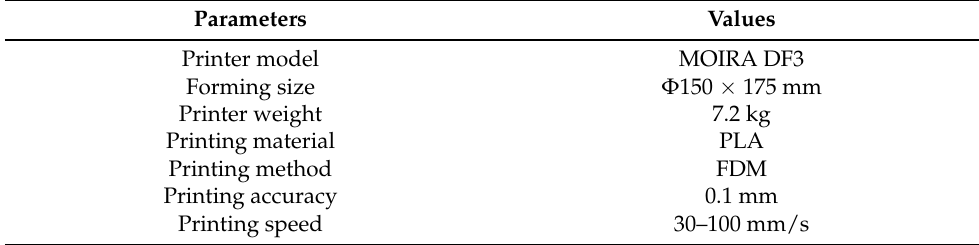
Table 1. DF3 printer parameter